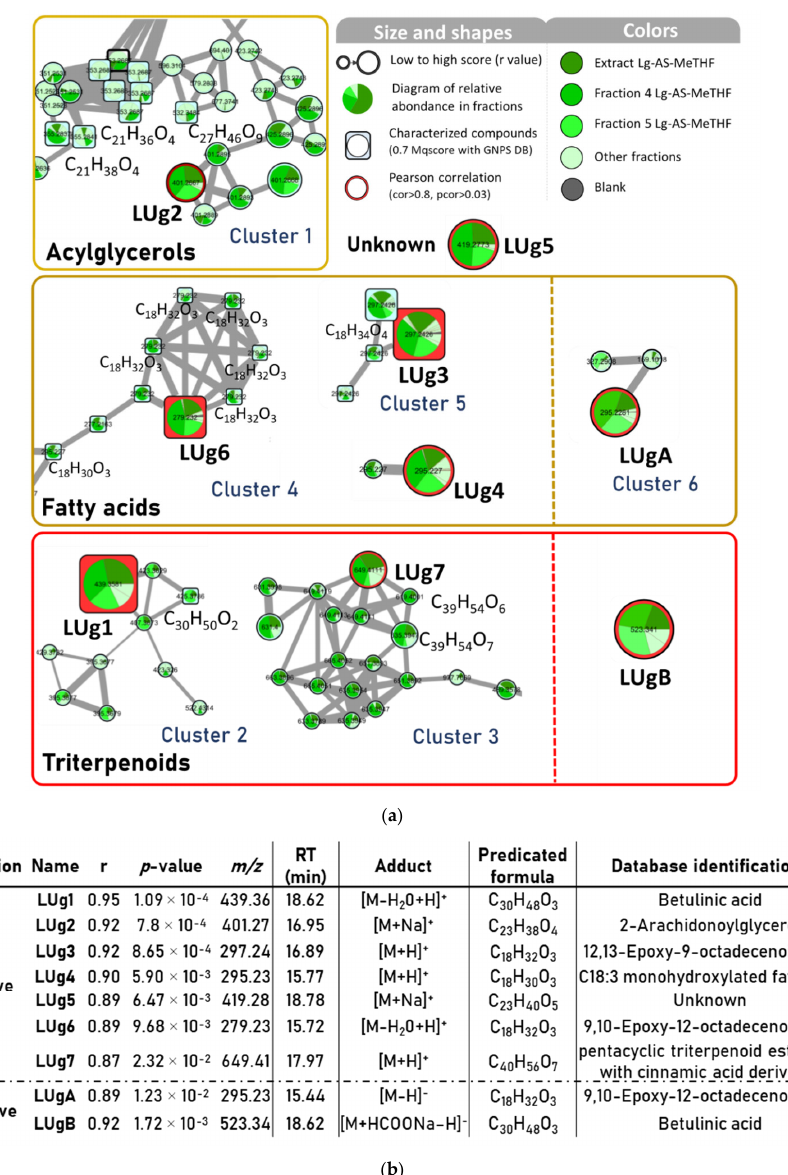
Figure 3. Feature-based molecular networks corresponding to L. grandiflora fractions and extracts. ( a ) Molecular networks generated from positive and negative ionization mode, with legend of represented ions. ( b ) List of bioactive correlated ions including correlations scoring (r), p ‐ value, m / z value, retention time (RT), adduct ions detected, predicted chemical formula and identification predicted by databases (GNPS, MetFrag).